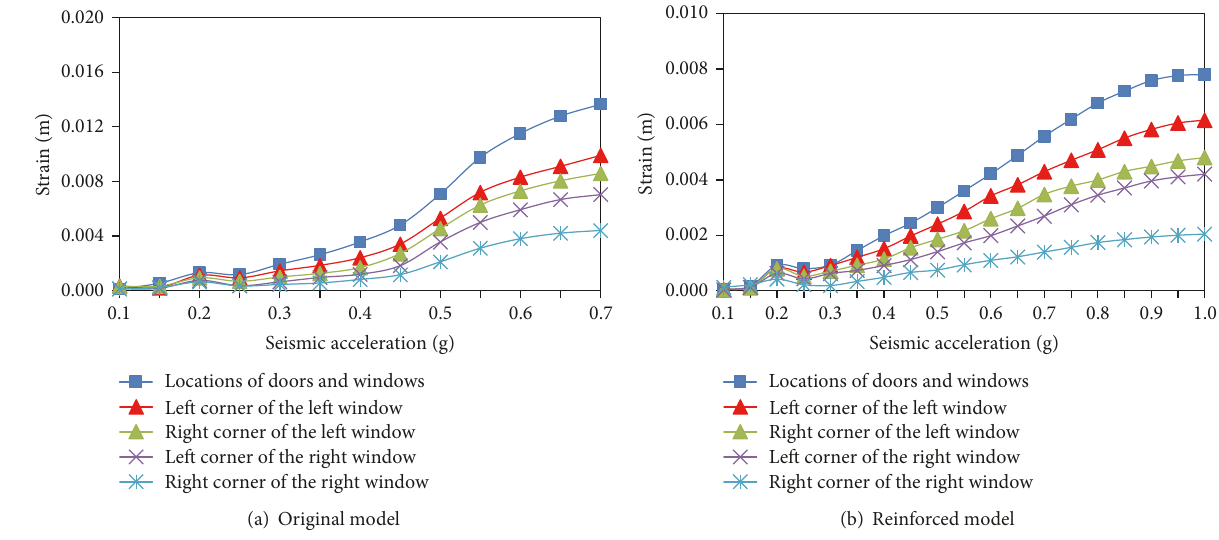
Figure 16: Strains of different positions on the masonry